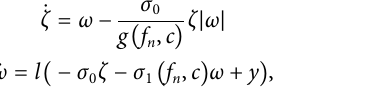
Frontiers in Robotics and AI |